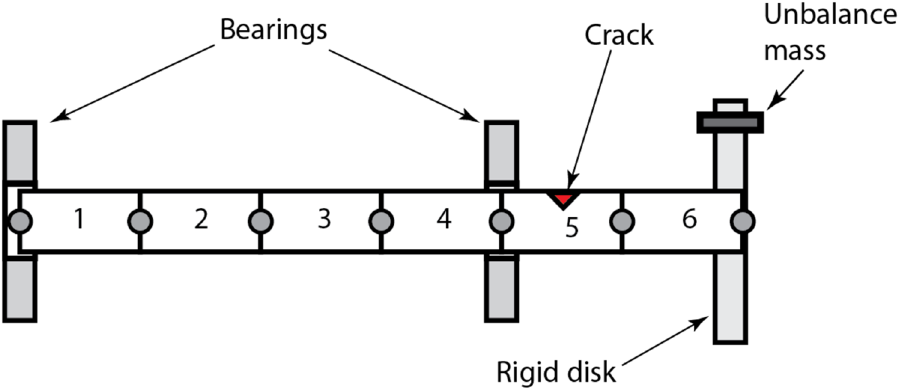
Figure 3. Schematic diagrams of the FE disk-shaft-bearing-rotor